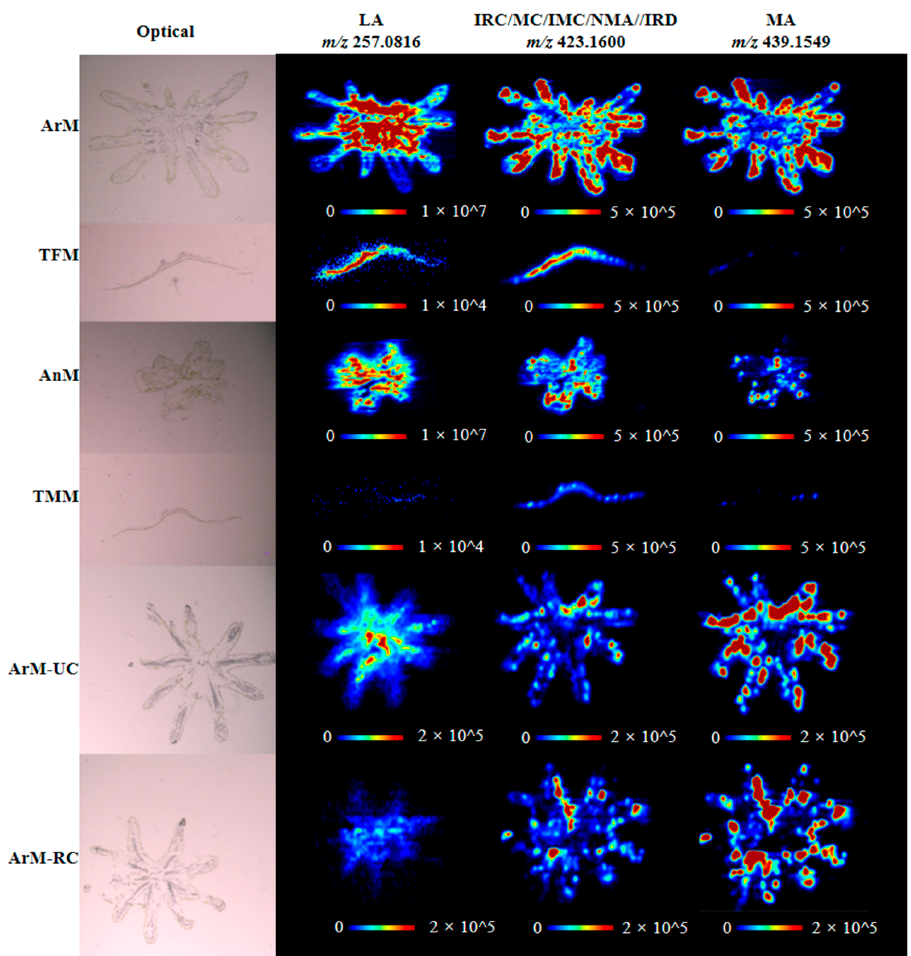
Figure 2. Spatial distribution of LA ( m/z 257.0816), IRC/MC/IMC/NMA/IRD ( m/z 423.1600), and MA ( m/z 439.1549) in M. polymorpha receptacles and thalli based on AFADESI-MSI